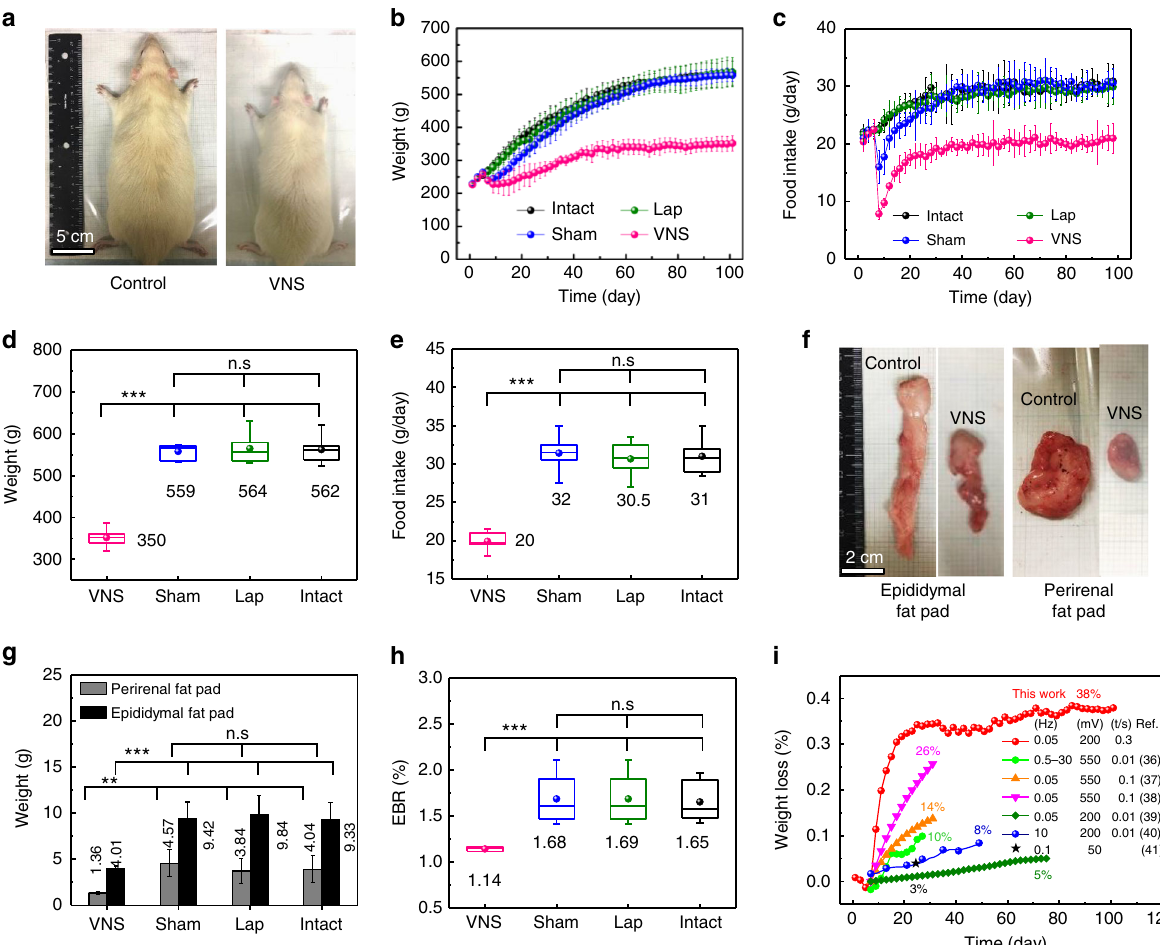
Fig. 4 Weight control during the weight-gaining growth stage of rats. a Representative images of body size of the VNS group ( n = 6) and the control groups (Sham, Lap, and Intact group, n = 6 for each group). b Average body weight of rats in different groups over time (implantation was performed after a week of observation period under normal conditions). c Rat ’ s food intake over time in different groups. d Final body weight of rats in different groups. e Final daily food intake in steady state of rats in different groups. f Representative images of white adipose tissue (epididymal fat pad and perirenal fat pad) of the VNS group and the control group. g Adipose tissue weight of rats in different groups. h Epididymal fat pad/body weight ratio (EBR) of rats in different groups. i Percentage of weight loss over time (black dots) in comparison to the reported results by chronic electric stimulation with a rectangular waveform (voltage, frequency, and pulse duration are also shown). All data in b , c , and g are presented as mean ± s.d. In d , e , and h (box plots), dots are the mean, center lines are the median, box limits are the lower quartile (Q1) and upper quartile (Q3), and whiskers are the most extreme data points that are no more than 1.5× (Q3 – Q1) from the box limits. Statistical analysis was performed by two-tailed unpaired Student ’ s t tests. n.s., non-signi fi cant ( P >